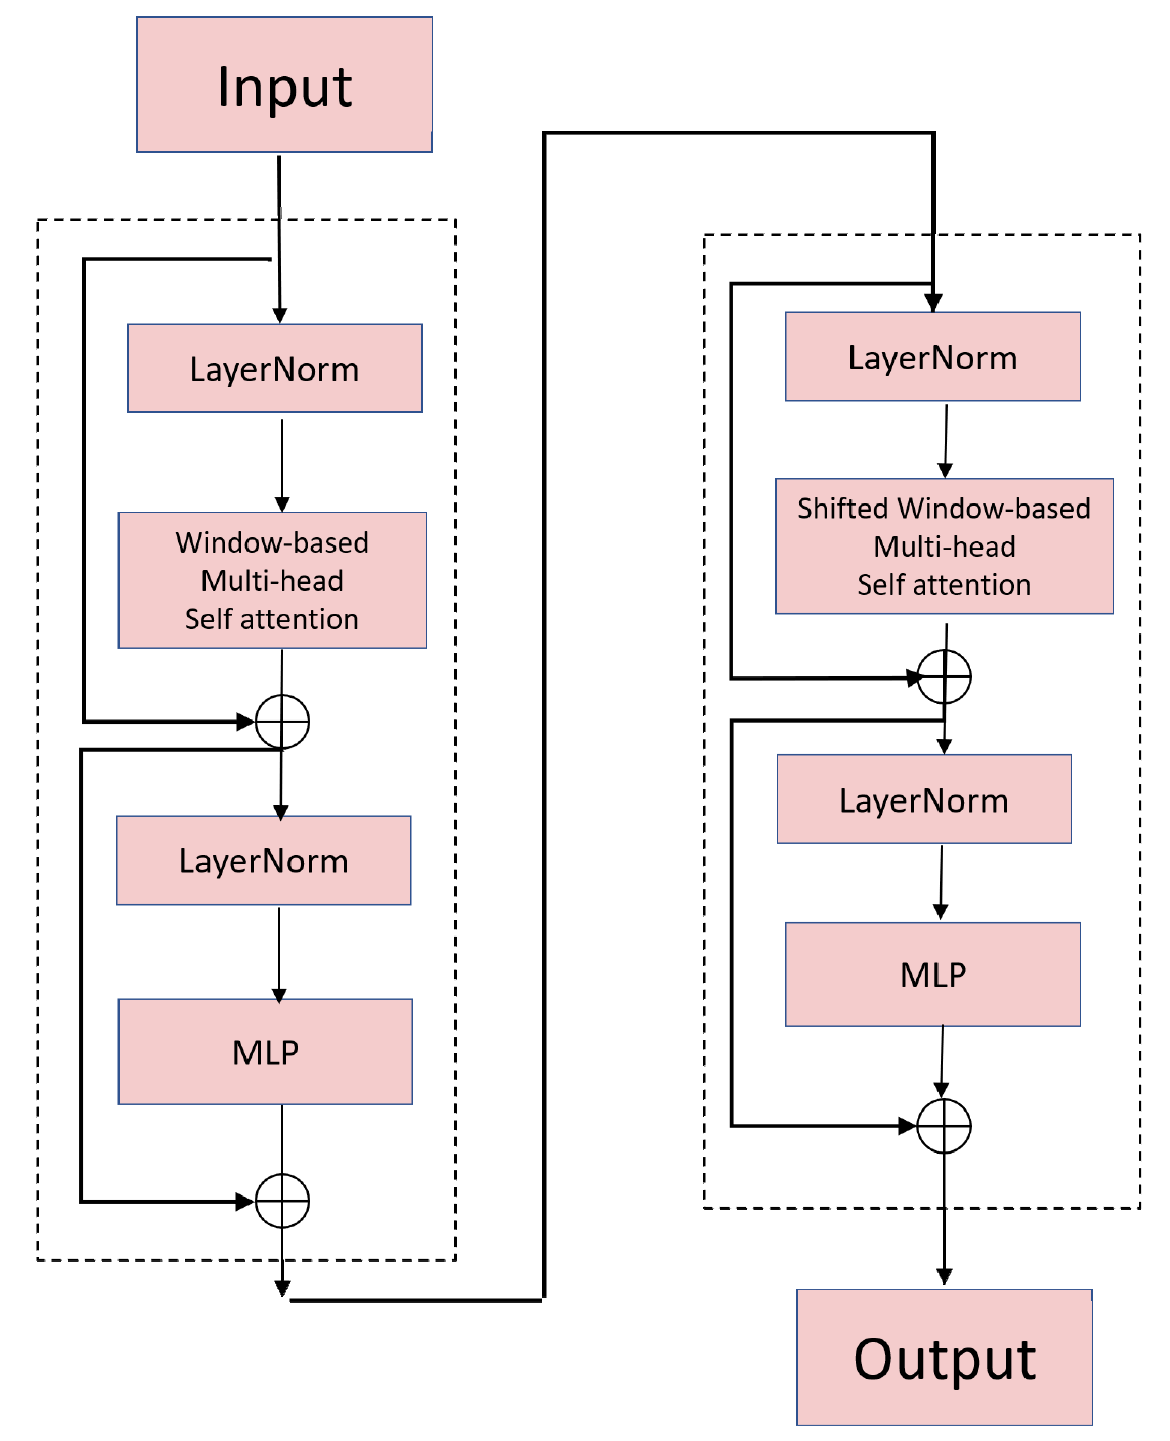
Figure 2. Two transformer blocks in Swin transformer in succession. MLP stands for multi-layer